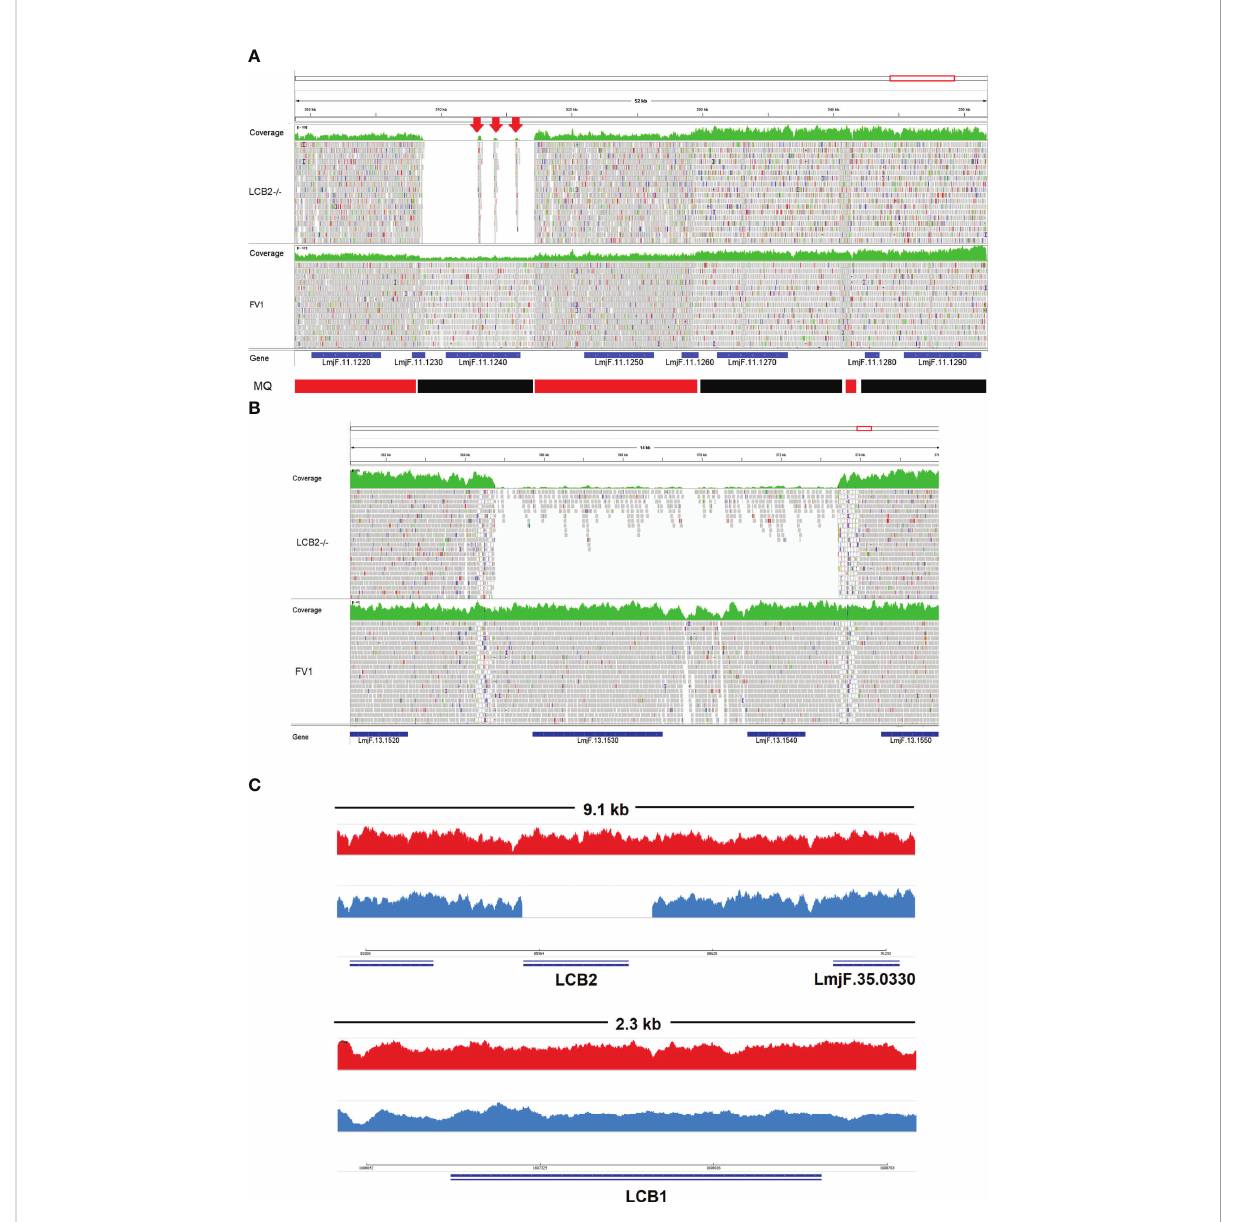
FIGURE 3 Visualization of the genomic region of non-targeted (A, B) and targeted gene deletions in L. major knockout ( Lmj LCB2-/-; C). A and B top (green) represent coverage, whereas A and B bottom show individual reads with mapping quality (MQ) of zero (white- fi lled bars) or between 40 and 60 (grey- fi lled bars) in FV1 (wild type) and Lmj LCB2-/- cell lines. The CDS (genes) are shown underneath A and B (blue bars). In A, the bottom banner indicates local read positions with mapping quality (MQ) from zero to <30 (red bars) or ≥ 60 (black bars). In Lmj LCB2-/-, the absence of reads alongside three mis-mapped interspersed contigs (red arrows) is shown in Lmj F.11.1240 (A) , and in Lmj F.13.1530 (miltefosine transporter) and adjacent gene LmjF.13.1540 (unknown function) (B) . Cartoon showing coverage in FV1 (red) and Lmj LCB2-/- (blue) of the two sub-units of serine palmitoyltransferase (SPT). Complete ablation of LmjF.35.0320 (LCB2 subunit) is shown in Lmj LCB2-/- but not in FV1 ( C , top) whilst Lmj F.34.3740 (LCB1 subunit) is unaltered in both cell lines ( C , bottom). WGS data from L. major wild type (FV1) and Lmj LCB2-/- were aligned to the reference genome (https://tritrypdb.org) and the image was produced using IGV_2.8.9 (Robinson et al., 2017) (http://software.